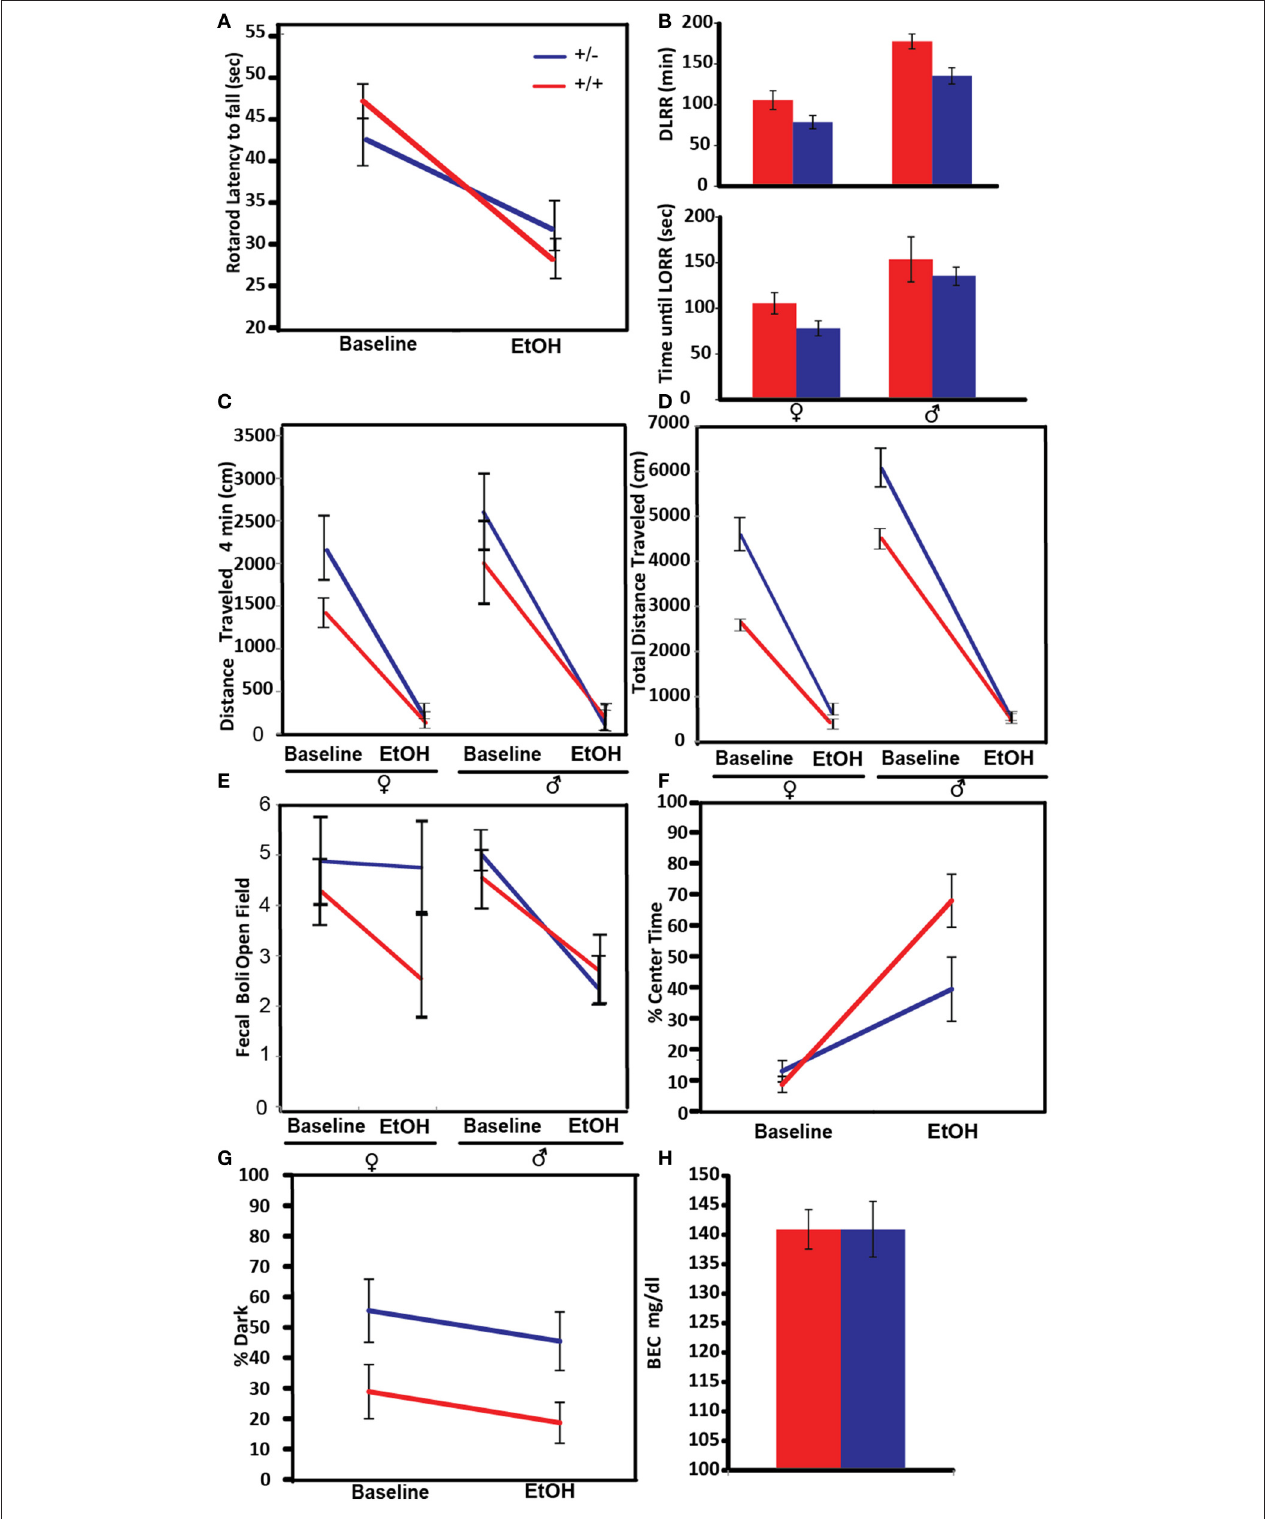
FIGURE 4 | Effects of Pafah1b1 heterozygous knock-out on the acute effects of alcohol on different behavioral and physiological traits. For each figure, red indicates WT mice and blue indicates Pafah1b1 heterozygous mutant mice. (A) Ataxia was measured via latency to fall from an accelerating rotarod before and after a 1.25 g/kg EtOH. (B) Sedation measured in response to 2.5 g/kg EtOH as measured by time until LORR and time to recovery from LORR (DLRR). (C) Distance traveled after the first 4min in a novel environment. (D) Total distance traveled in a novel environment. (E) Anxiety as measured by counts of fecal boli in the open